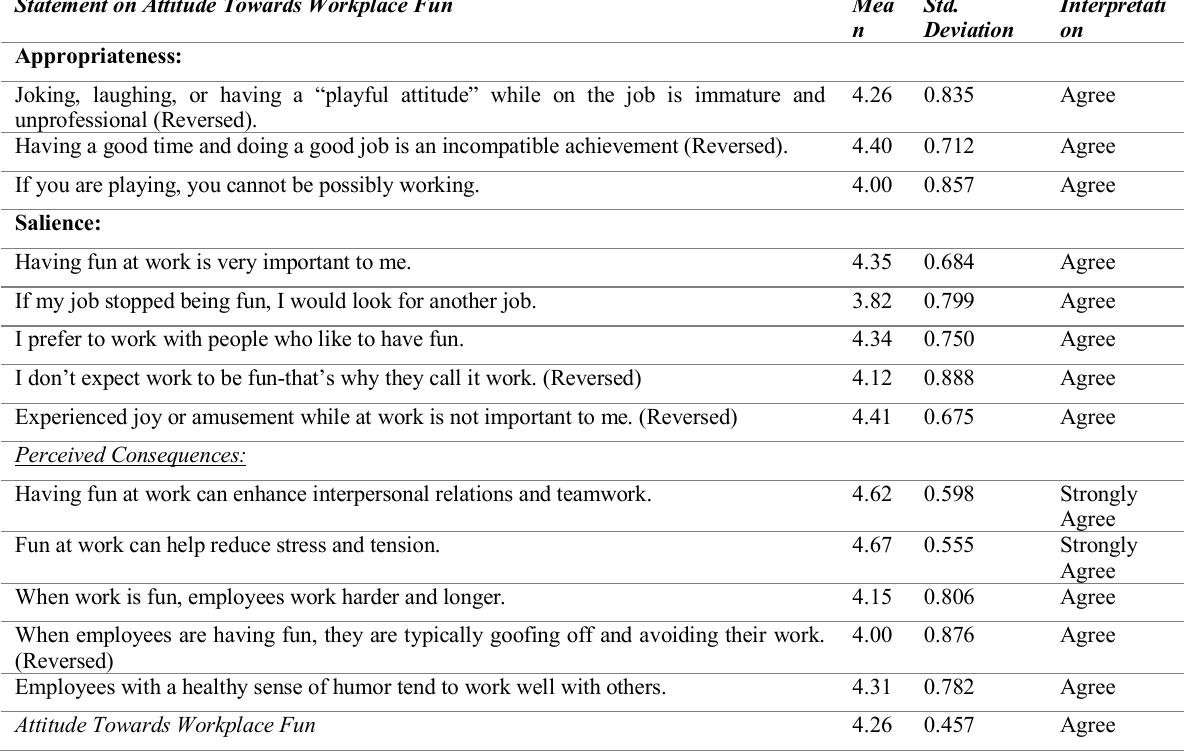
Table 3: Mean of statement on attitude towards workplace fun